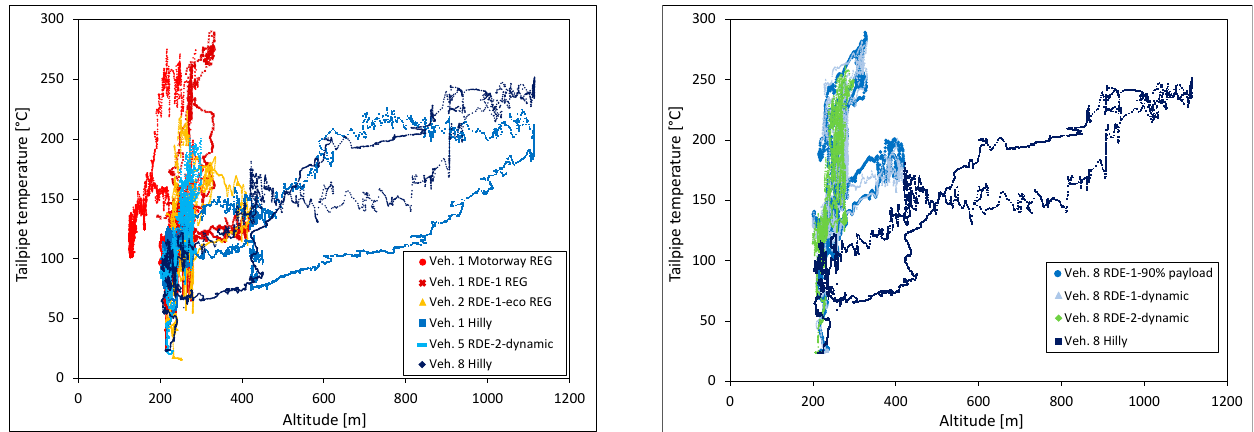
Figure 4. Correlation of tailpipe temperature with altitude for various driving conditions. ( Left ): Impact of DPF regeneration, vehicle mode, uphill driving, dynamic driving. ( Right ): Impact of payload, dynamic driving, uphill driving with a low-powered LCV.